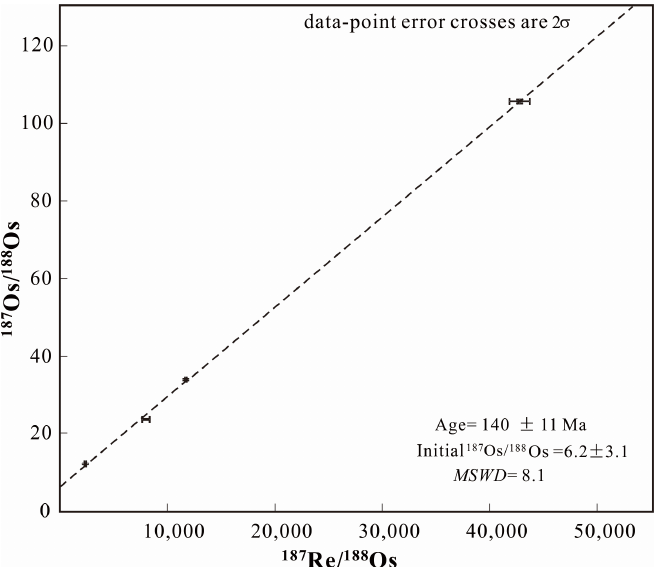
Figure 10. The pyrite Re-Os isochron age of Fe-Cu mineralization in the Shuikoushan